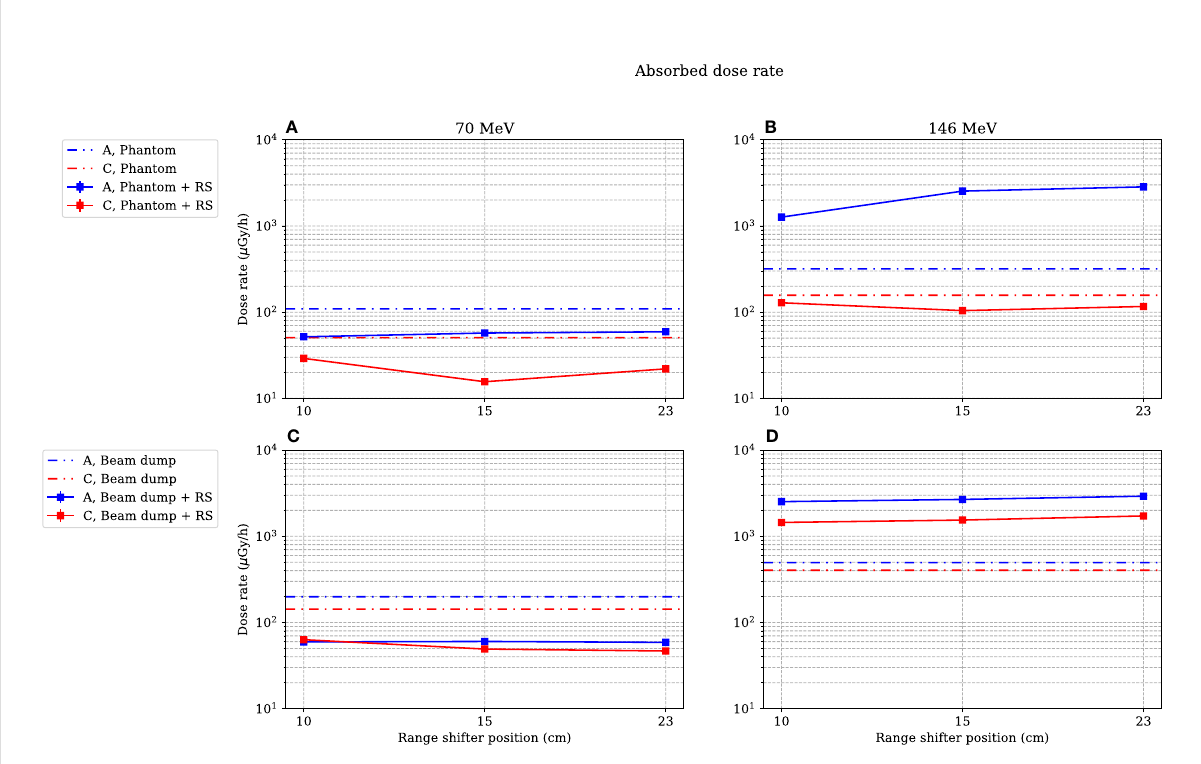
FIGURE 4 Absorbed dose rate for both 70-MeV (left fi gures) and 146-MeV (right fi gures) proton beam irradiations. The range-shifter positions correspond to the air gaps when the phantom was present. In (A, B) , the phantom was irradiated, while in (C, D) , no phantom was present and the beam was instead irradiating the proton beam dump situated by the far wall. The lines between data points are used as guide for the eye. The dashed – dotted lines show the levels without a range shifter, i.e., scattered from the phantom or from the beam dump. As mentioned in Section 2.4, the values are illustrated with statistical uncertainties only with k =